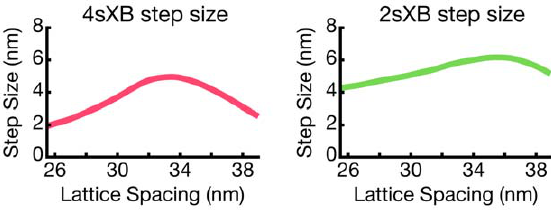
Figure 6. Changes in step size with lattice spacing. Step size varies as lattice spacing diverges from its rest value. Step size is defined as the change in the rest axial offset between the pre- and post-power stroke states. The step size of the 4sXB model and 2sXB model produce different absolute step sizes as lattice spacing change. However, both models exhibit a local maximum step size at a specific lattice spacing with a decreasing step size as lattice spacing diverges from that